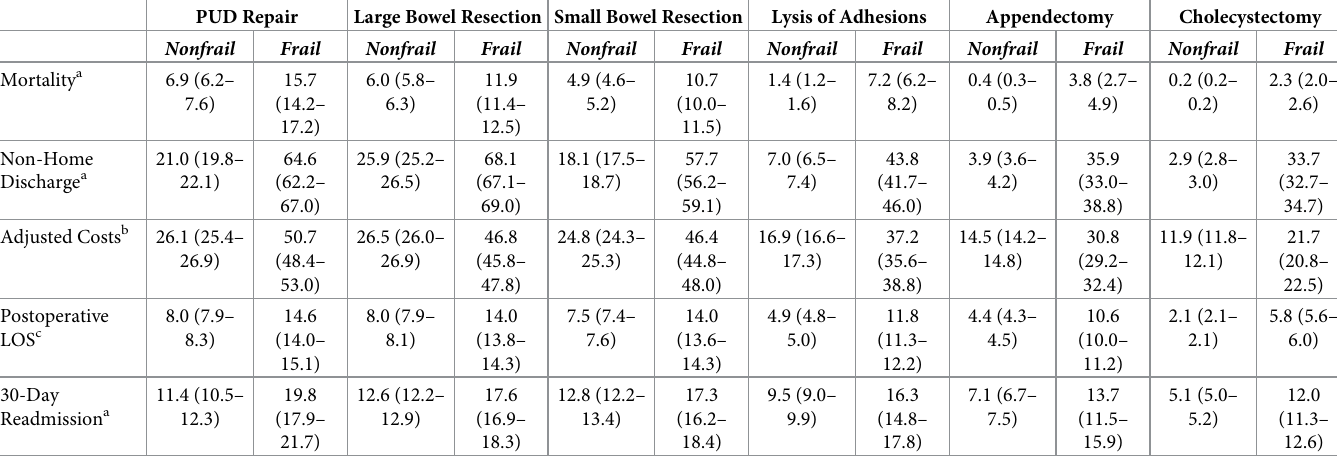
Table 2. Adjusted outcomes for all EGS operations by Nonfrail and Frail cohorts, stratified by